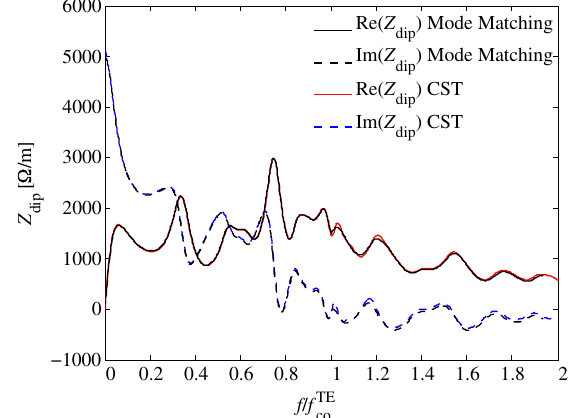
FIG. 8. Comparison of mode matching and CST . Mode matching parameters: b ¼ 5 cm, t ¼ 25 cm, L ¼ 20 cm, σ